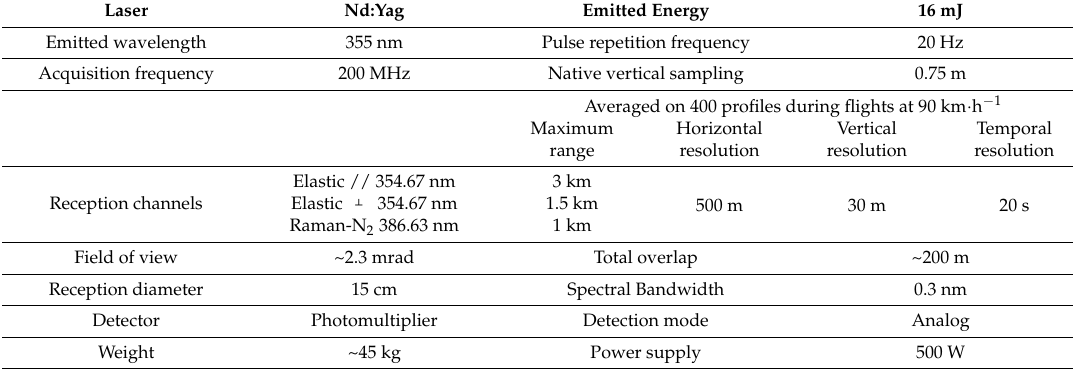
Table 3. Lidar for Atmospheric Surveys using Raman Scattering (LAASURS) main characteristics. Laser